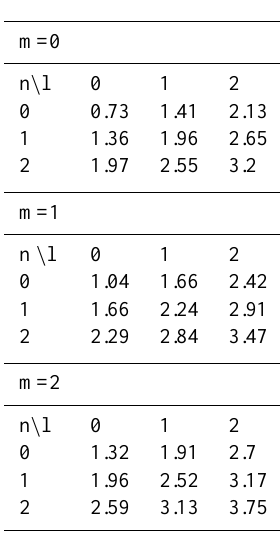
Table 1. Eigenfrequencies of the MHD resonator in the NEPS – f mnl